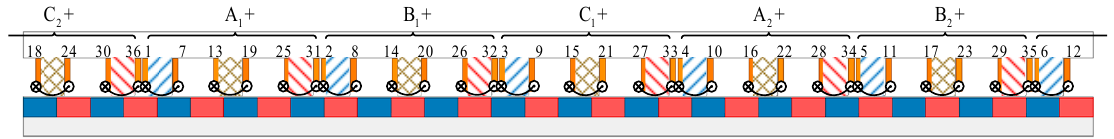
Figure 5. Equivalent 2D machine model (expanded at middle radius).